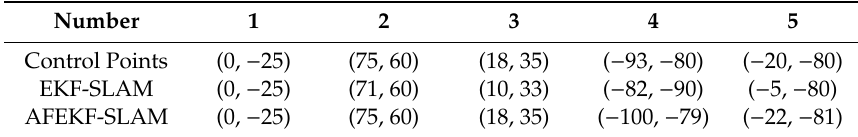
Table 3. Optional five control points (in meters).